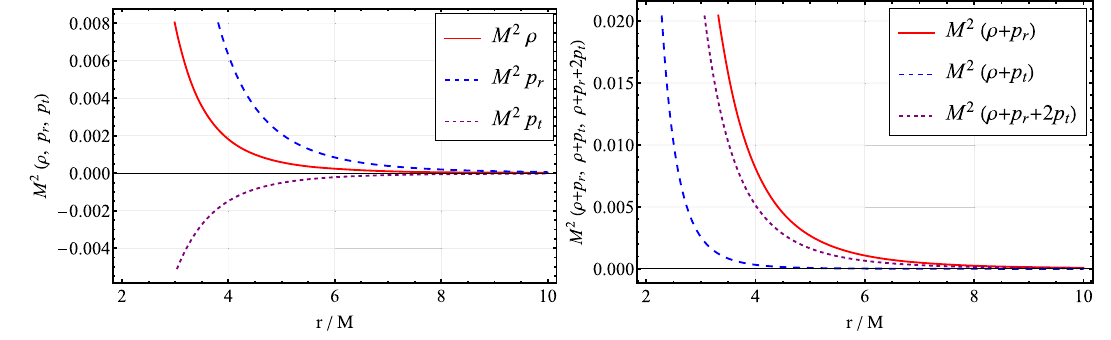
Fig. 1 Matter components ρ , p r and p t (left panel) and combinations ρ + p ρ + p ρ + p + 2 p r , t ,and r t (rightpanel)asfunctionsofthenormal- ized radial coordinate r / M with α = 3, β = 2, λ = − 9 π , r 0 = 2 M ,